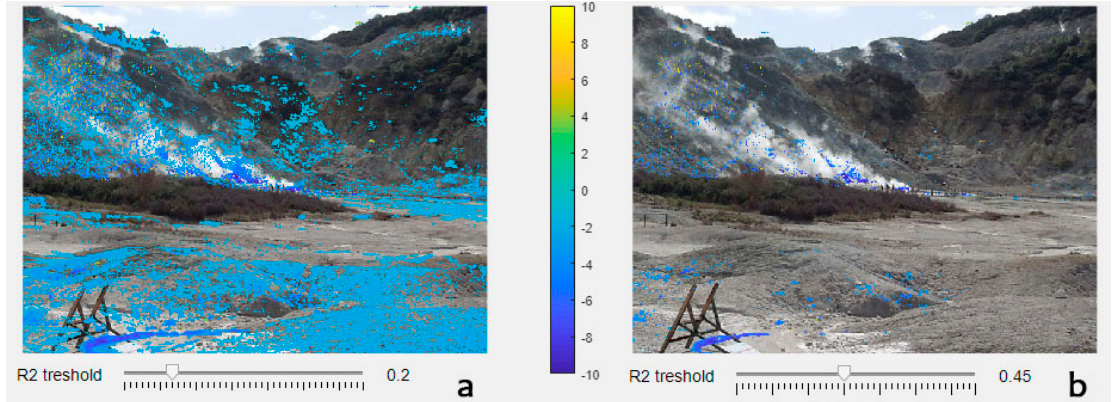
Figure 7. Yearly rate of temperature change maps of SF1 in the period 2016.02.01 – 2016.11.30. Map ( a ) has R 2 threshold value = 0.2. Map ( b ) has and R 2 threshold value = 0.45. In this time-interval SF1 maximum temperatures decreased of about 10 °C as evidenced by the color map.